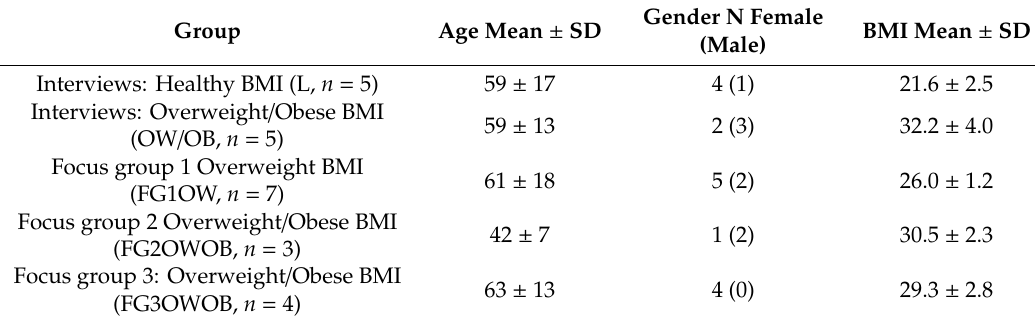
Table 1. Population